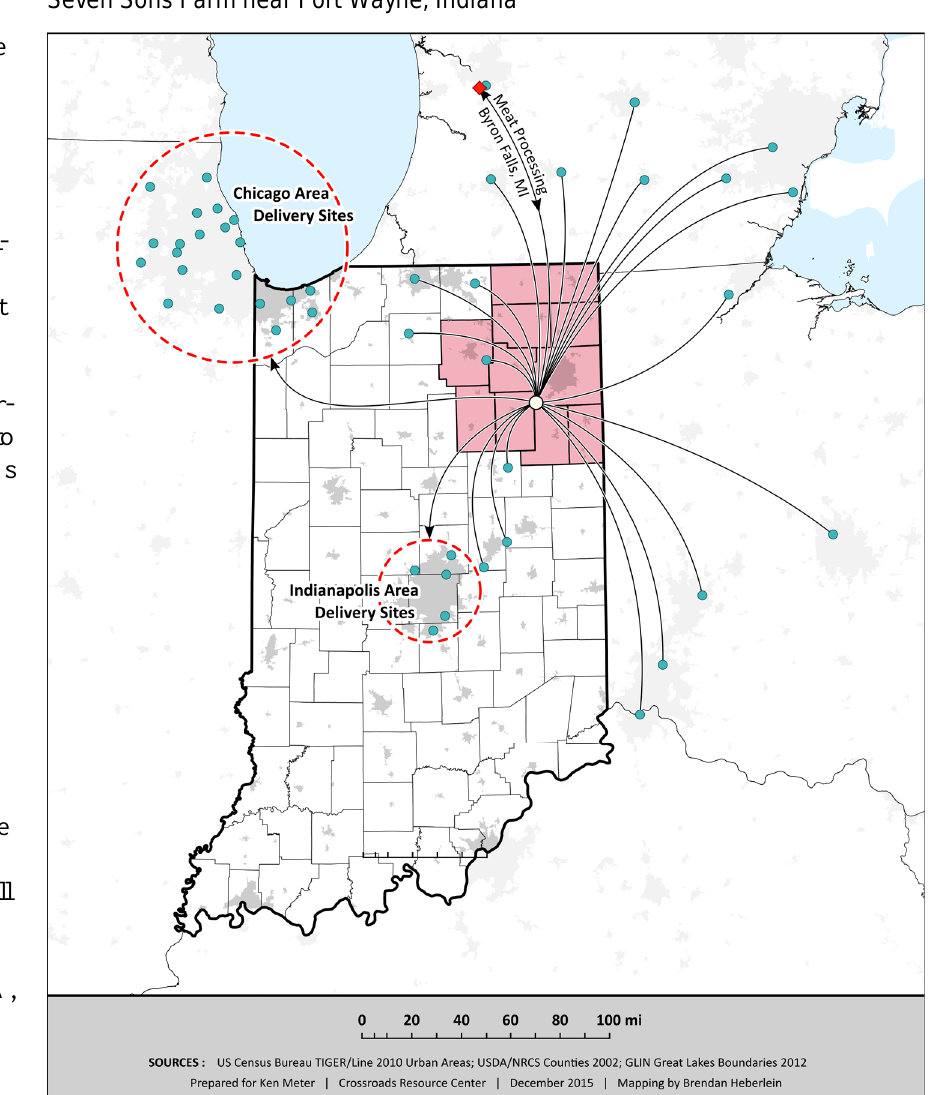
Figure 1. Map of the Commercial Network of Delivery Sites Developed by Seven Sons Farm near Fort Wayne,